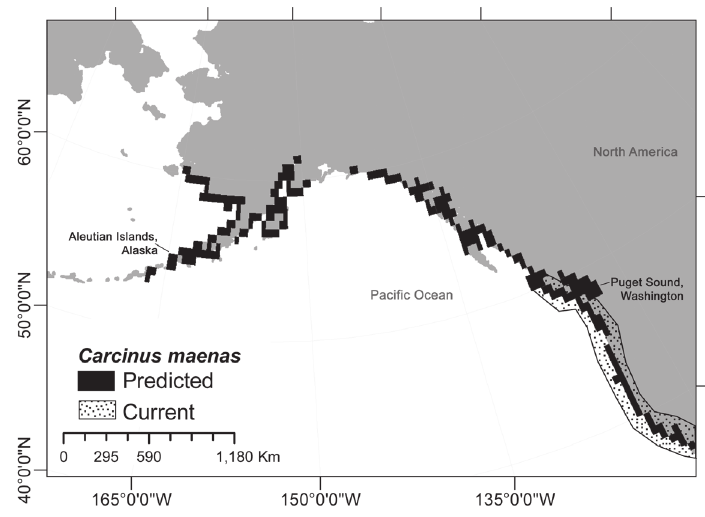
Figure 1. Potential Carcinus maenas distribution for the northeast Pacific coast from Northern California to Alaska, USA. The current nonnative distribution along the coast is indicated by a broad, stippled polygon, while the potential distribution of the species is plotted in black. Figure and MaxEnt potential distribution model from deRivera et al. 83 , figure altered to clarify the absence of C. maenas from Puget Sound. This figure has been adapted and reproduced with kind permission from Diversity and Distributions, ©